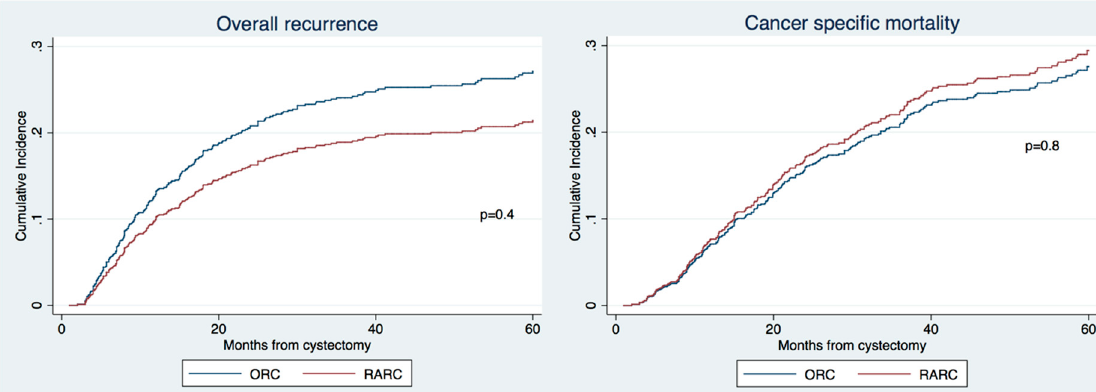
Figure 2. Cumulative incidence of recurrence and cancer specific mortality of patients with non-metastatic BCa treated with radical cystectomy according the type of surgery (ORC vs. RARC) after 2:1 propensity matching for age, pathological T stage, pathological N stage, neoadjuvant chemotherapy (NAC) and grade. Table 4. Multivariable competing risk analyses predicting the risk of overall recurrence and CSM in patients treated with radical cystectomy after propensity matching.